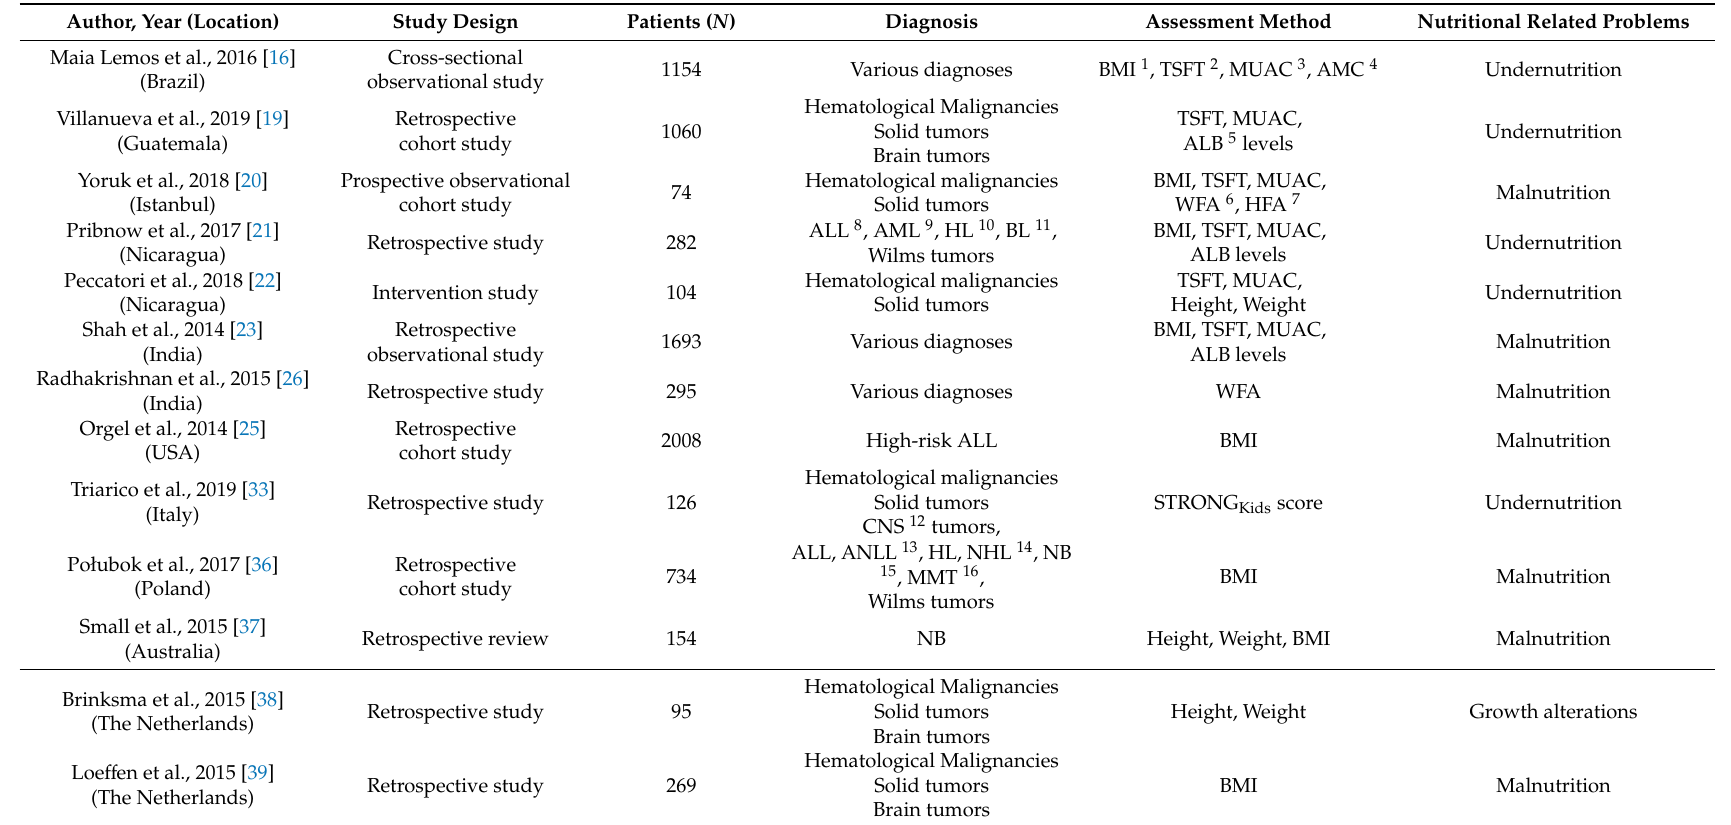
Table 1. Characteristics of listed studies that assess NS at